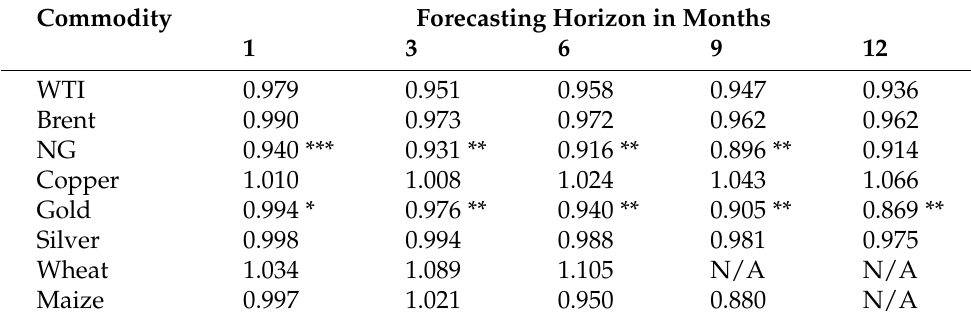
Table 1. RMSFE ratio for nominal commodity price forecasts.